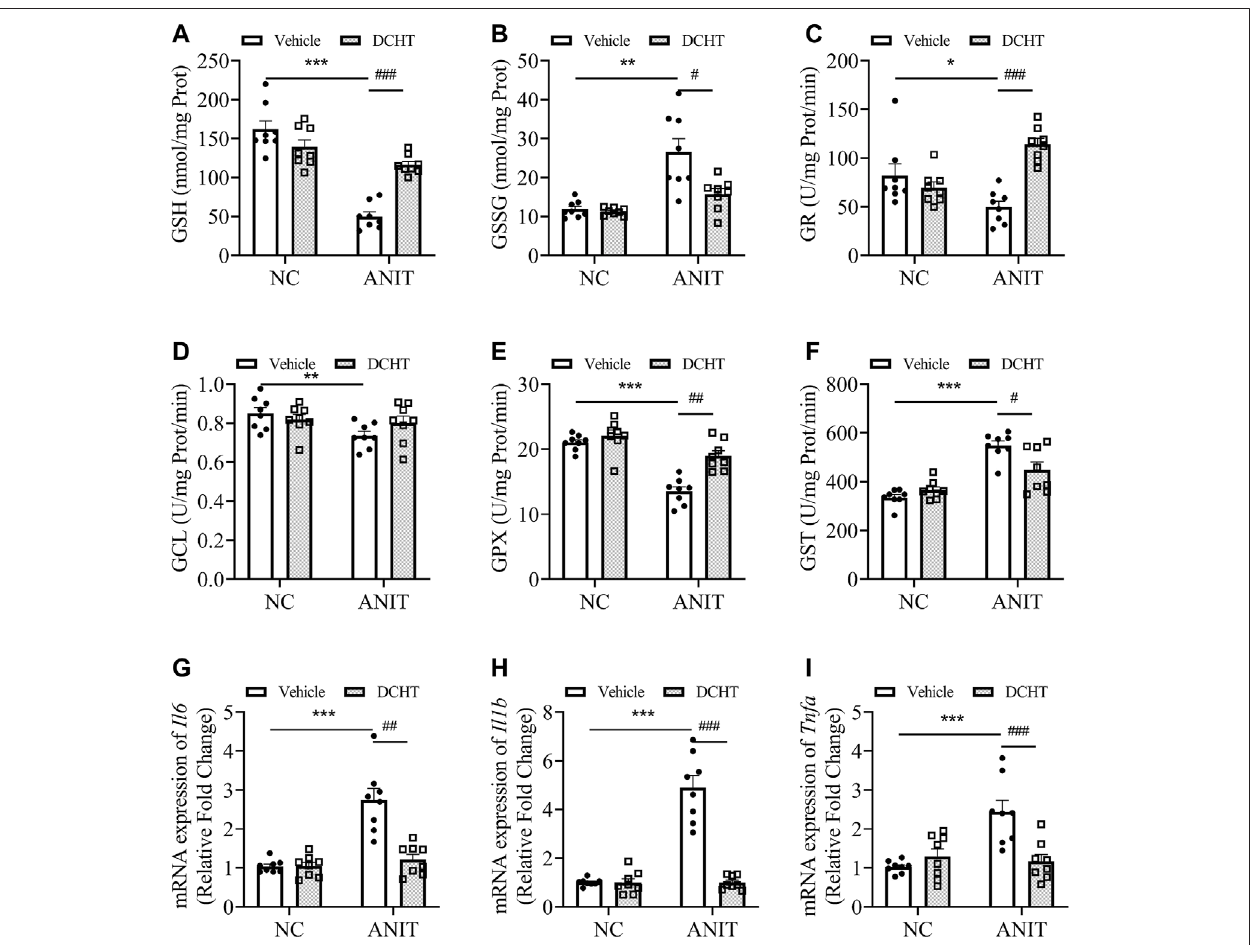
FIGURE3 | DCHT regulates hepatic glutathionehomeostasisand in fl ammationin ANIT-induced intrahepatic cholestasismice. (A-F) Hepatic activities ofGSH (A) , GSSG (B) , GR (C) , GCL (D) , GPX (E) and GST (F) in the liver were measured after treatment of mice with ANIT (2 days) and/or DCHT (5 days, 1.875 g/kg), as indicated (G-I) mRNA expression of Il6 (G) , Il1b (H) and Tnfa (I) in the liver was measured by RT-qPCR after treatment of mice with ANIT (2 days) and/or DCHT (5 days, 1.875 g/kg), as indicated. Data are shown as means ± SEM.; * p < 0.05, ** p < 0.01, *** p < 0.001 compared with the vehicle group. # p < 0.05, ## p < 0.01, ### p < 0.001 compared with the ANIT treatment group, n =